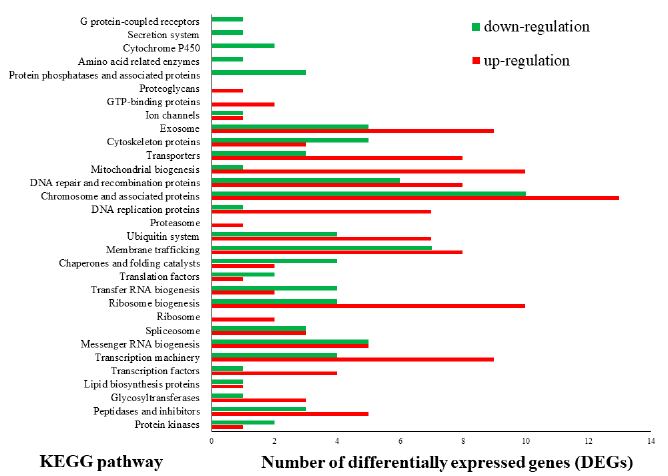
Figure 2. EuKaryotic Orthologous Groups (KOG) function classifications of differentially expressed genes (DEGs, absolute fold change value set to ≥ 2 and p < 0.05) under blue light. Functional predictions of DEGs were classified into 25 functional classes by the KOG database, and the functional classes are shown according to the number of DEGs.